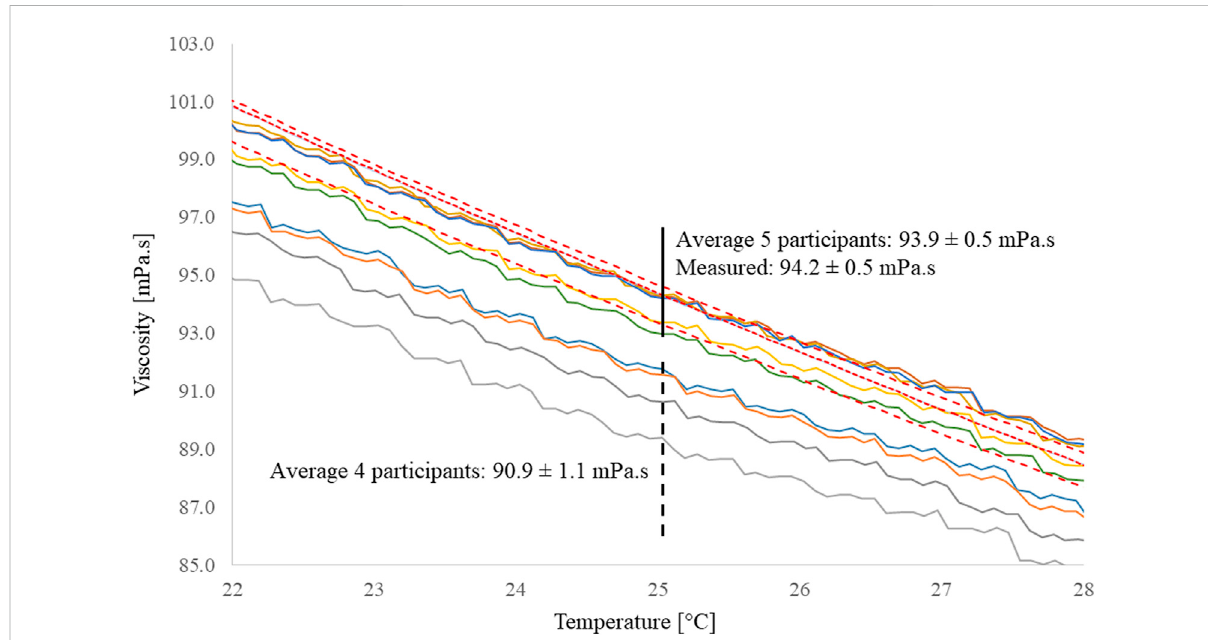
FIGURE 5 Viscosity curves for the silicone oil used in the measurements. The three curves in dashed line were obtained in this study, while the other nine curves were provided by the benchmark participants. At a temperature of 25 ° C, the average viscosity of the obtained measurements is 94.2 ± 0.5 mPa s which is in good agreement with the viscosity reported in fi ve of the provided curves, 93.9 ± 0.5 mPa s, but considerably different for the remaining fourcurves average90.9 ±1.1 mPa s.Thedifferencesbetweencurvesare mostlikelydueto differentmeasurement protocols asthe silicone oil is from the same